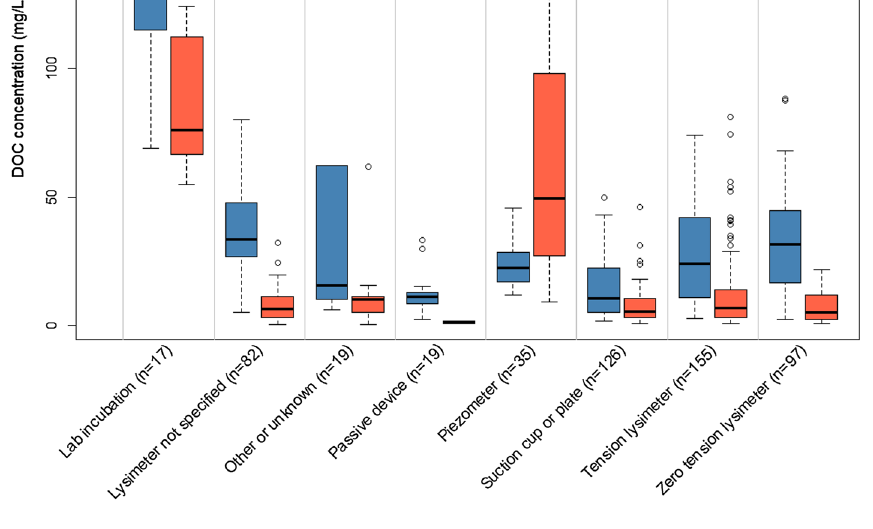
Fig. 4 Precipitation data from [61] versus DOC concentra- tions (mg C/L) (n = 533). Laboratory incubation data are excluded. Five DOC subsoil peat values (111.25–372.1) are not shown, but included in the regression. R 2 values for all data, topsoil data and subsoil data are respectively 0.0325, 0.129 and 0.0073, only sig- nificant for all data and topsoil data ( p < 0.0001